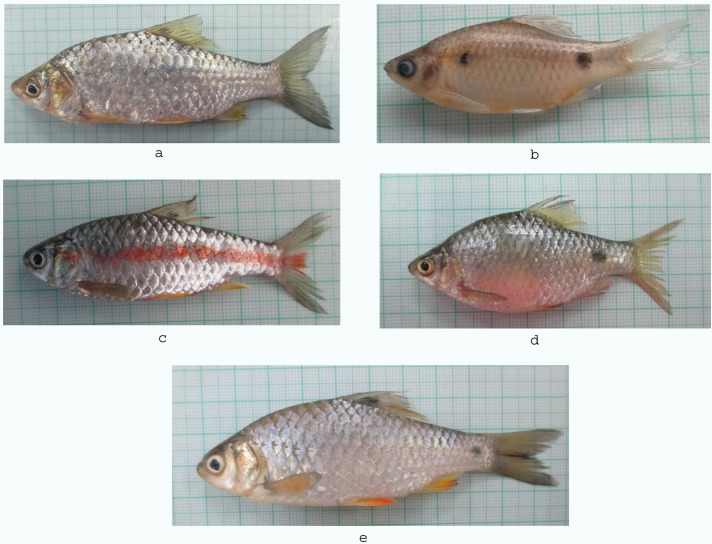
Representative specimens of each species (a) S. sarana (b) P. ticto (c) P. sophore, (d) P. conchonius and (e) P. chola.